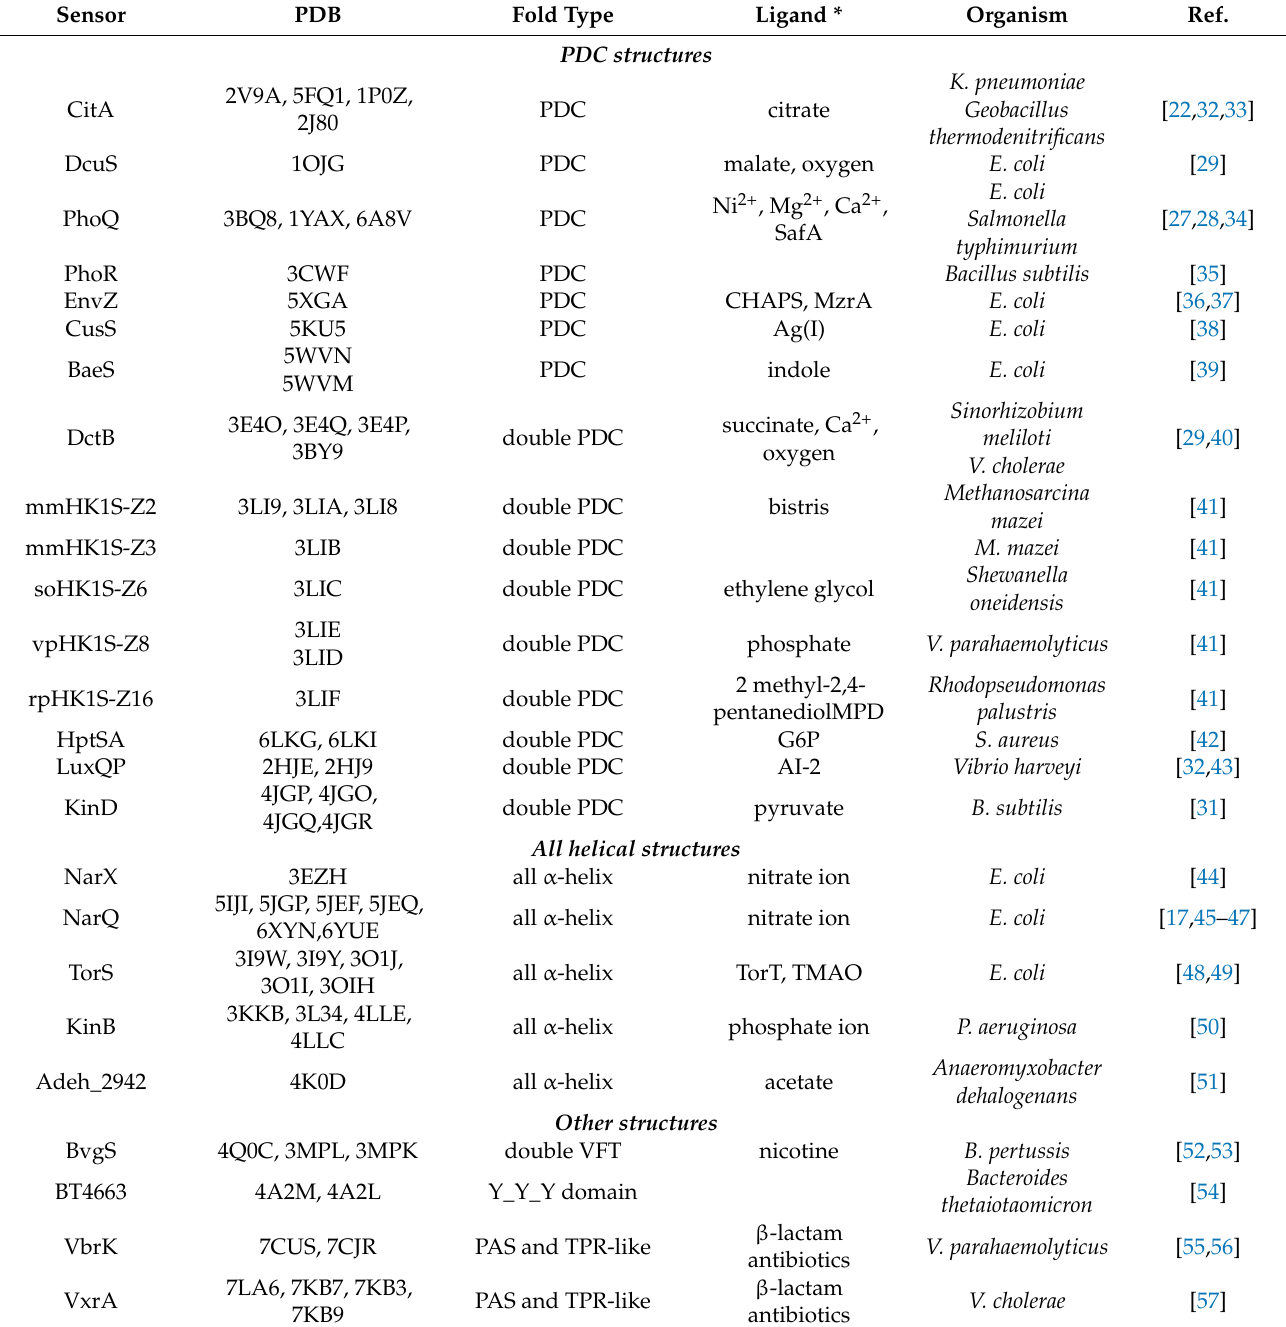
Table 1. Signal Sensing by Extracellular domain of